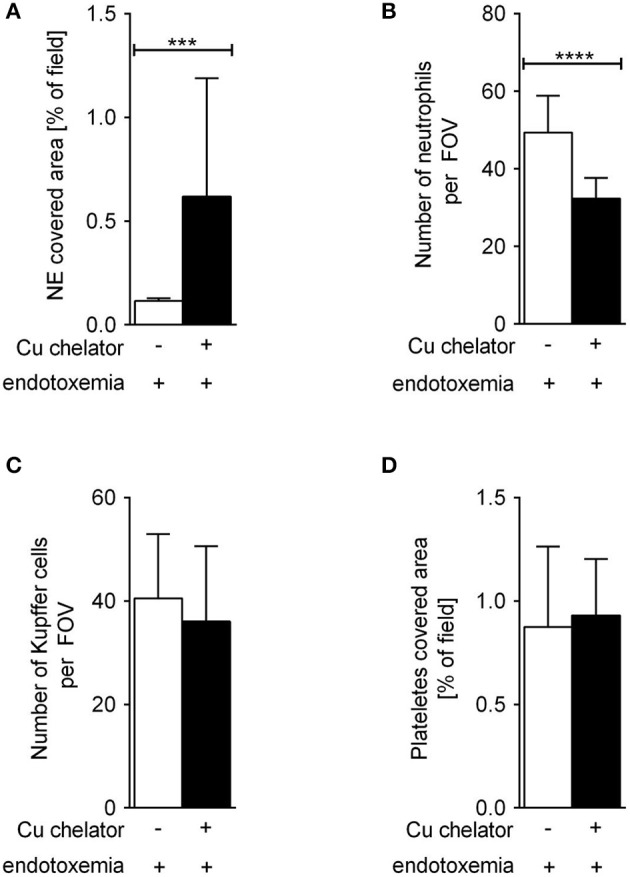
The impact of subchronic copper deficiency on NET formation (A), neutrophil numbers (B), Kupffer cell counts (C), and platelet covered area (D) in C57Bl/6J mice. Copper chelator (Cu chelator) was administered for 8 days and then LPS-systemic inflammation was induced. NET covered area and cell counts were performed 24 h later. Asterisks indicate significant differences using unpaired two-tailed Student's t test (***P ≤ 0.001, ****P ≤ 0.0001).